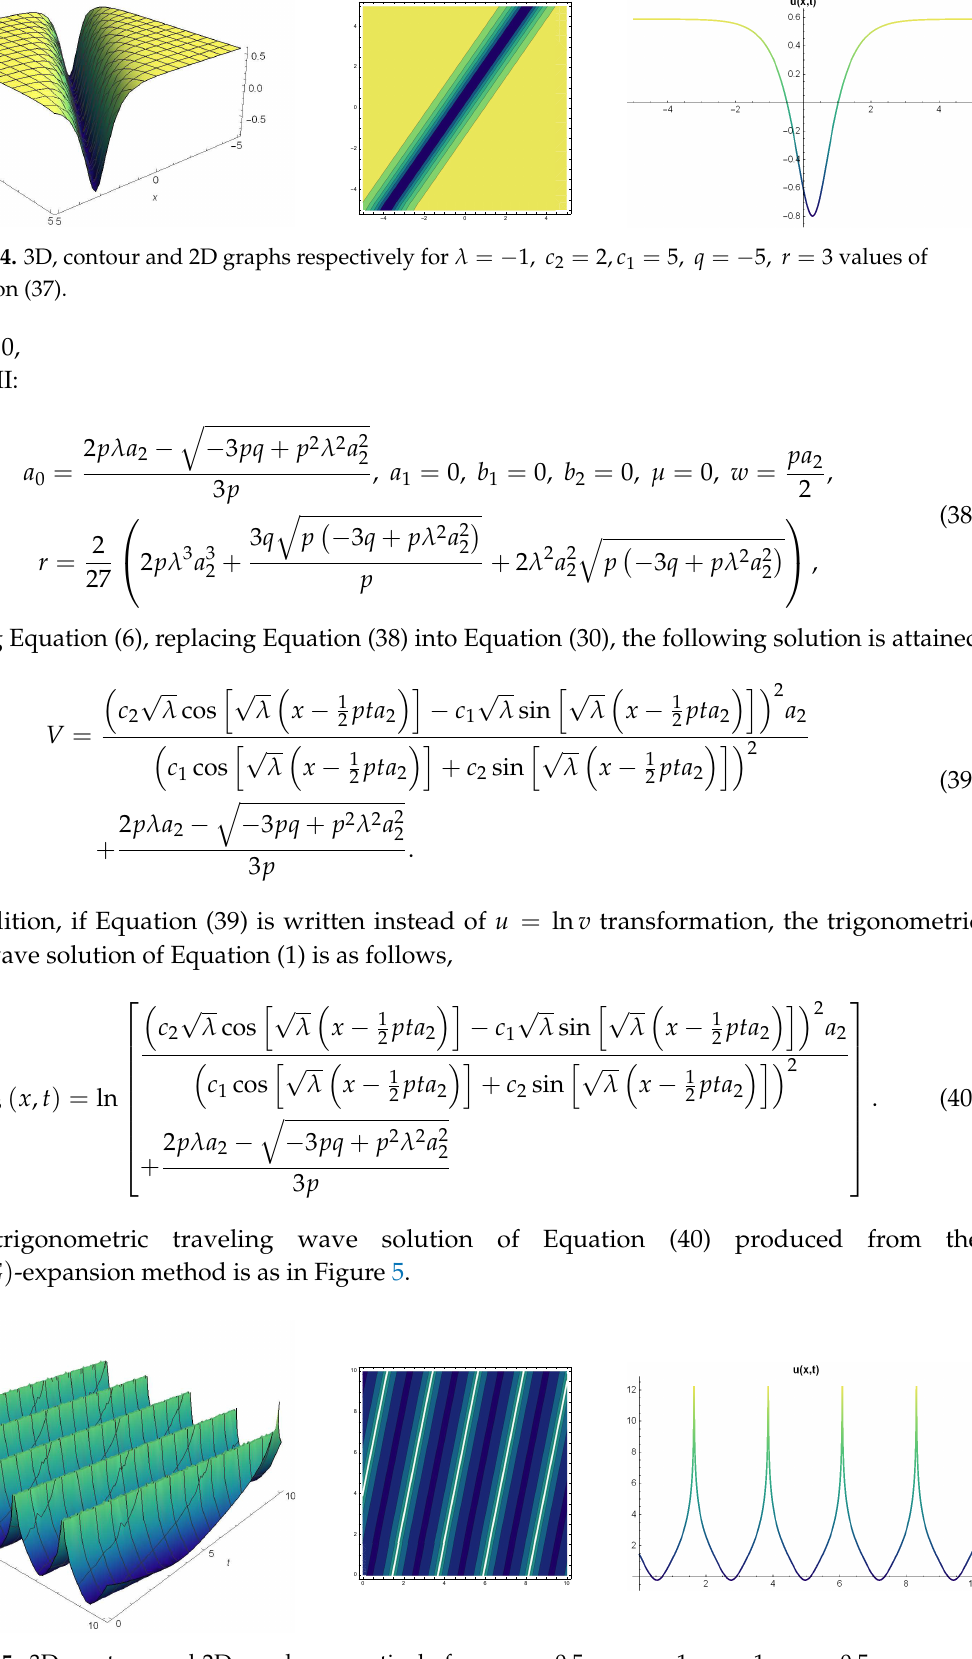
Figure 5. 3D, contour and 2D graphs respectively for c 2 = − 0.5, c 1 = − 1, q = 1, a 0 = 0.5, p = − 0.2, λ = 2, a = − 2 values of Equation 2